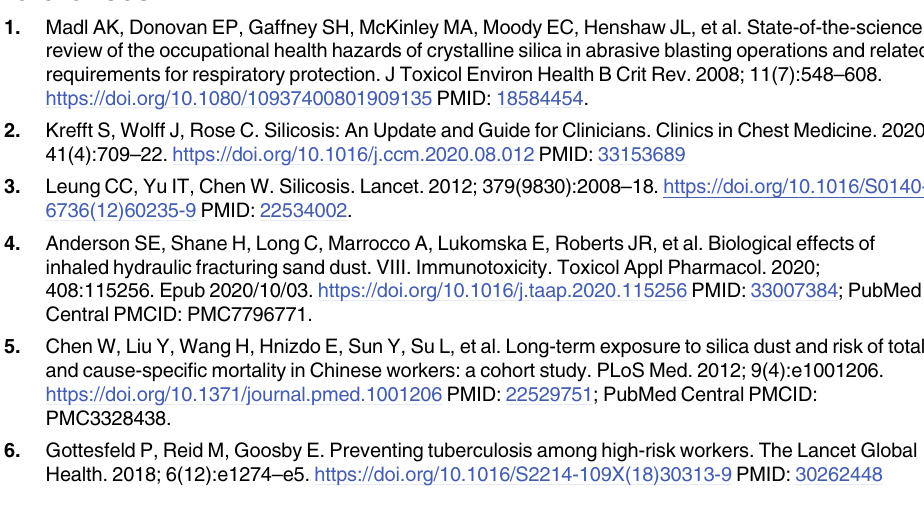
S1 Table. Protein identified in two or more independent experiments. S2 Table. Phosphorylation sites quantified in two or more independent experiments. S3 Table. The normalized changes of phosphorylation sites based on their protein levels. S4 Table. Significant differential metabolites in four or more independent